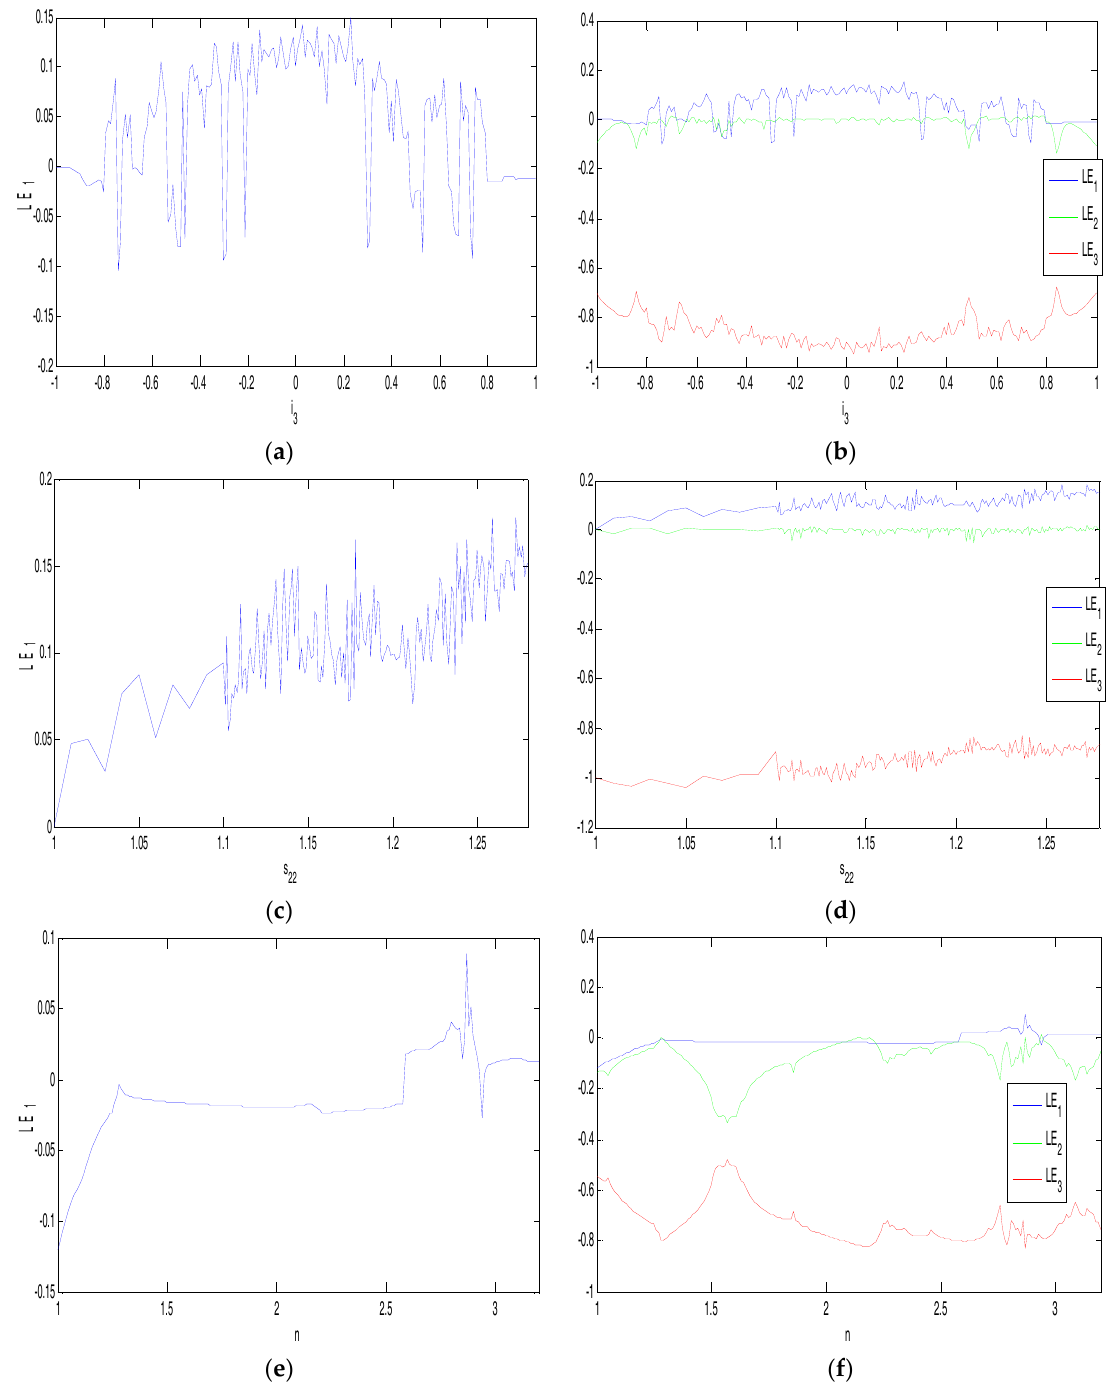
Figure 3. ( a ) Diagram of largest Lyapunov exponent for i 3 ∈ [ − 1, 1]; ( b ) Lyapunov exponents of the system for i 3 ∈ [ − 1, 1]; ( c ) diagram of largest Lyapunov exponent for s 22 ∈ [1, 1.3]; ( d ) Lyapunov exponents of the system for s 22 ∈ [1, 1.3]; ( e ) diagram of largest Lyapunov exponent for n ∈ [1, 3.5]; and ( f ) Lyapunov exponents of the system for n ∈ [1, 3.5].